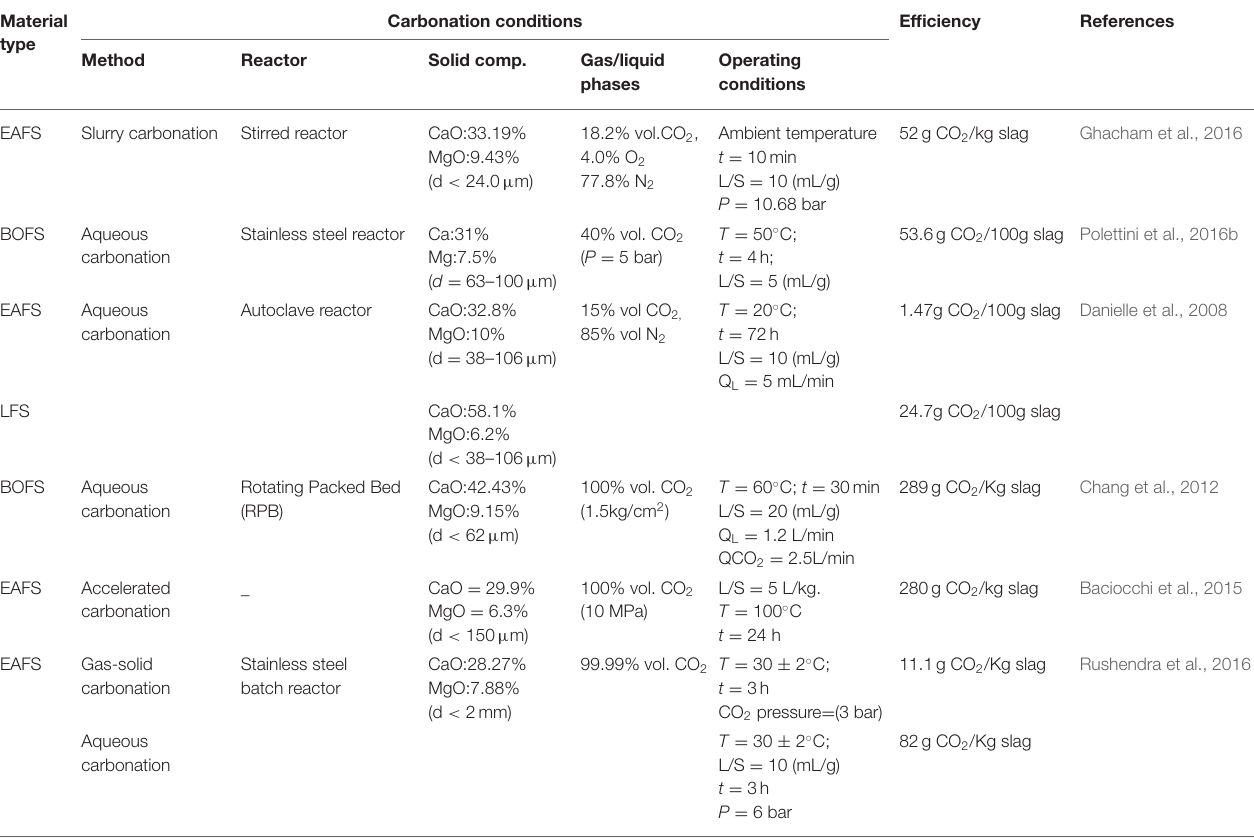
TABLE 1 | Carbonation efficiency of different kinds of SS operating under various